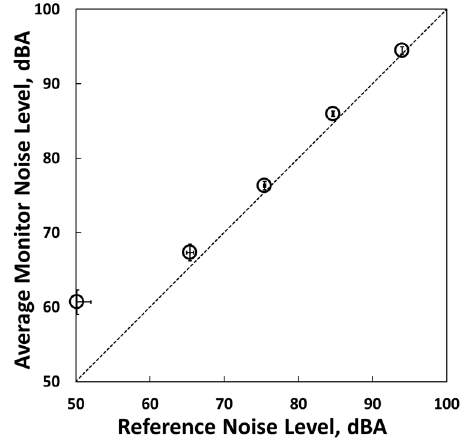
Figure 8. Average noise sensor measurements relative to the reference measurements. The x -axis and y -axis error bars represent one standard deviation.